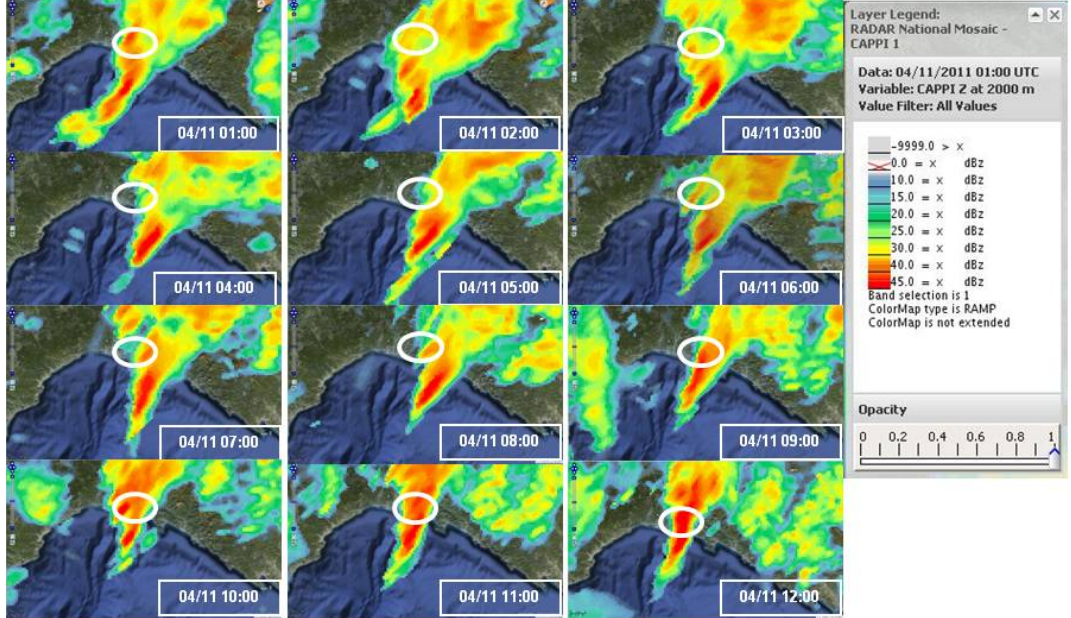
Fig. 5. The hourly developing of the finger-like auto-regenerating structure over the Genoa city, 4 November 2011, reflectivity Cappi at 2000m from 01:00UTC to 12:00UTC, Italian Radar Mosaic Network, flooded area marked by a white